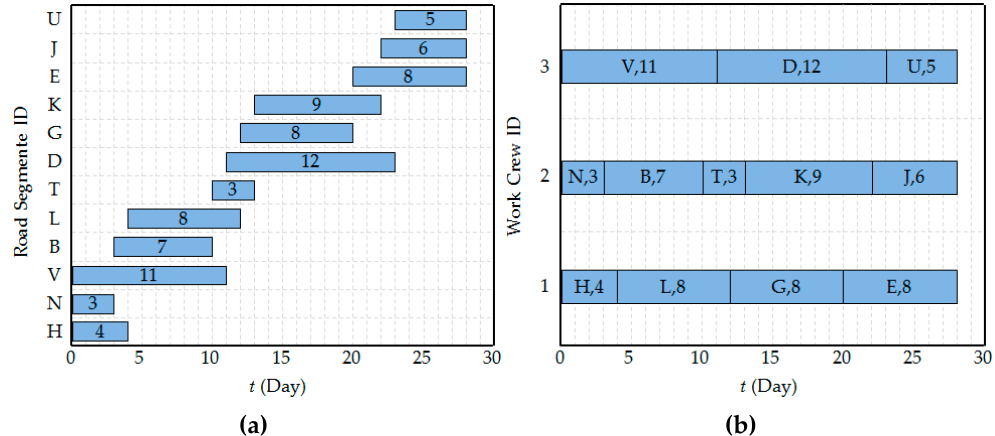
Figure 3. Optimal restoration schedule. ( a ) Time sequence of restoration activities; ( b ) job sequence of work crews.